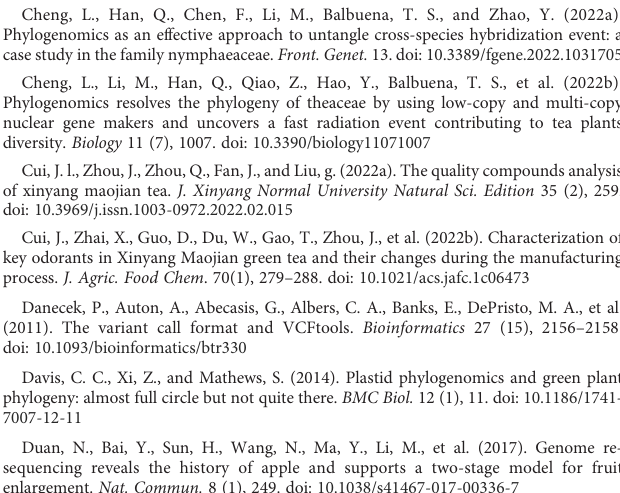
SUPPLEMENTARY FIGURE 2 The KEGG and GO annotation and enrichment analyses of 31 genes under positive natural selection (top 10% Fst values) were identi fi ed based on per-site by VCFtools. (A) The KEGG annotation for 31 genes with strong selection signals and the size of the star represents the number of genes, and the node color representsconnectivity. (B) TheX-axisshows genenumbers, andthe Y-axislists the categories in plant GO slim terms. Red, blue and green bars represent biological processes, molecular functions and cellular components, respectively. SUPPLEMENTARY FIGURE 3 The KEGG and GO annotation and enrichment analyses of genes located in the strong positive natural selection in genomic blocks by XP-CLR. (A) The size of the star represents the number of genes, and the node color represents connectivity. The pathway terms with red color enriched are shared by Camellia sinensis var. assamica (CSA) and Camellia sinensis var. sinensis (CSS). The pathway terms with blue and black colors represent CSA-speci fi c and CSS- speci fi c, respectively. (B) The X-axis shows gene numbers, and the Y-axis lists the categories in plant GO slim terms. Red, blue and green bars represent biological processes, molecular functions and cellular components, respectively. The GO terms with blue and black color indicate Camellia sinensis var. assamica speci fi c and Camellia sinensis var. sinensis , respectively. SUPPLEMENTARY FIGURE 4 The analysis of gene family and identi fi cation of gene duplication events (GDs) for those 53 genes under positive natural selection were identi fi ed both by single locus and genomic blocks. (A) Copy number variation of 51 gene families (homologs) across 11 genomes. The gene copy numbers for the CSS and CSA were shown in the purple and blue dotted boxes, respectively. The numbers represent the gene family copy number in the heatmap and the asterisk (*) indicates that the copy number of CSS varies largely compared to those in CSA. CSS-SCZ , CSS ‘ Shuchazao ’ ; CSS-LJ43, CSS ‘ Longjing43 ’ ; CSS-BY , CSS ‘ Biyun ’ ; CSS-HD , CSS ‘ Hangdan ’ ; CSS-TYG , CSS ‘ Tieguanyin ’ ; CSA-YK10 , CSA ‘ Yunkang 10 ’ ; C. lanceoleosa , Camellia lanceoleosa ; C . oleifera, Camellia oleifera var. ‘ Nanyongensis ’ ; C. DASZ , Camellia DASZ; A. chinensis, Actinidia chinensis ; R. simsii, Rhododendron simsii. (B) The heatmap for the number of gene duplications at different species tree nodes (node ID as phytos). The blue and yellow dotted boxes represent the number of gene duplication events for the genomes of CSS and CSA . (C) The heatmap represents the number of GDs occurredwithin thespecies level.TheGDnumbersofCSSandCSAwereshown in the purple and blue dotted boxes,